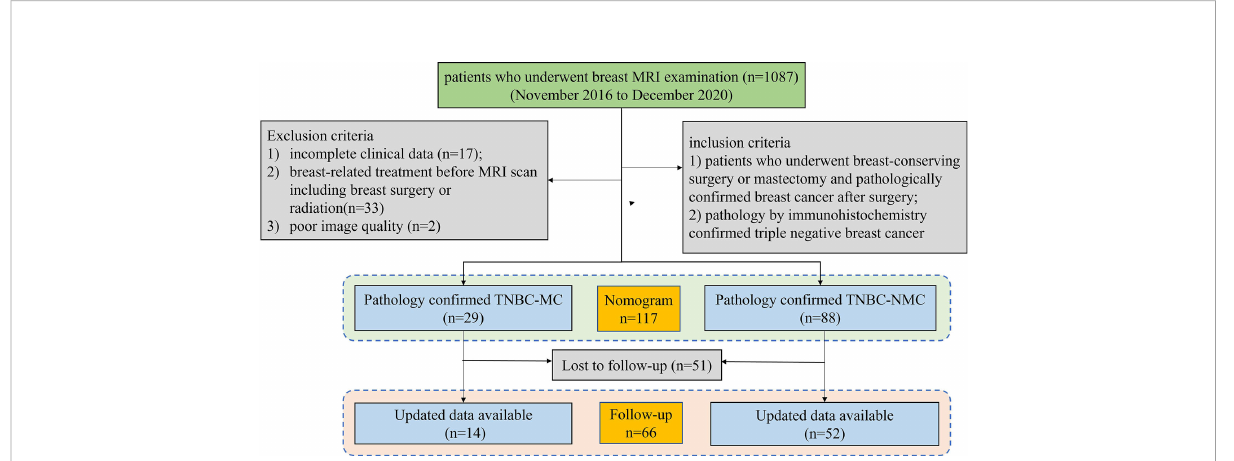
FIGURE 1 Flowchart of the patient selection and exclusion criteria. MRI, magnetic resonance imaging. TNBC;MC; triple negative breast cancer-metaplastic carcinoma; TNBC-NMC, triple negative breast cancer- non metaplastic